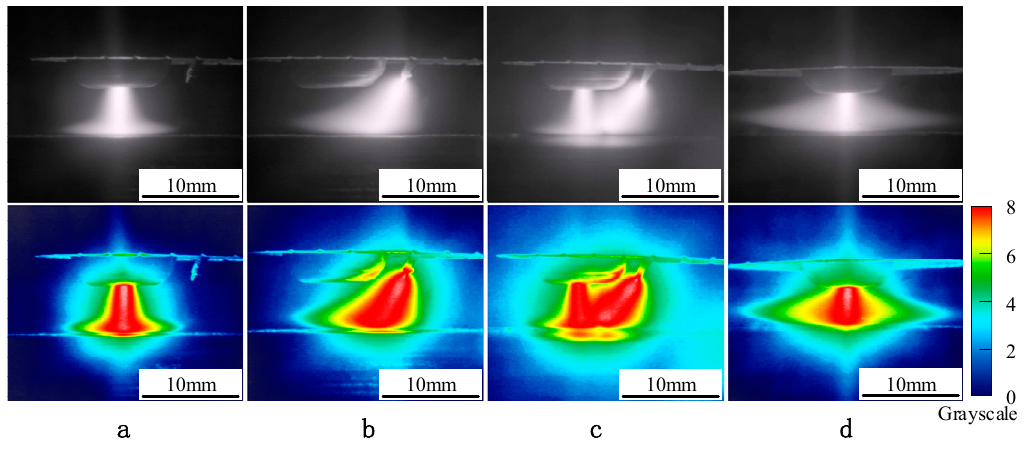
Figure 2. Arc profile under different welding methods. ( a ) Single plasma arc. ( b ) Single TIG arc. ( c ) Coupled arc perpendicular to the welding direction. ( d ) Coupled arc parallel to the welding direction.